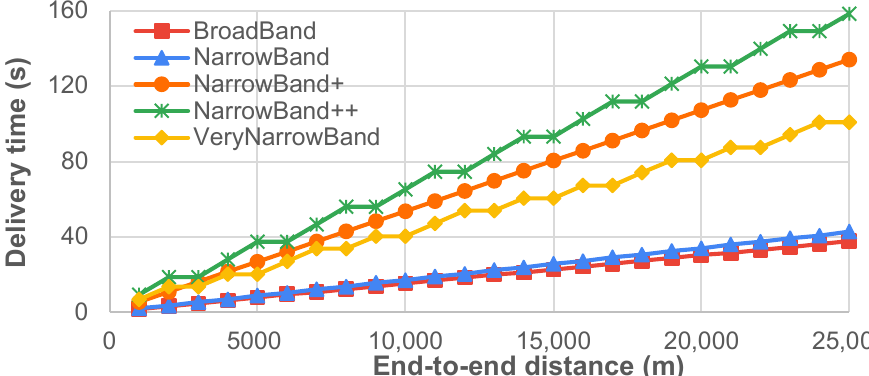
Figure 11. End-to-end delivery time in the case of no-loss multi-hop